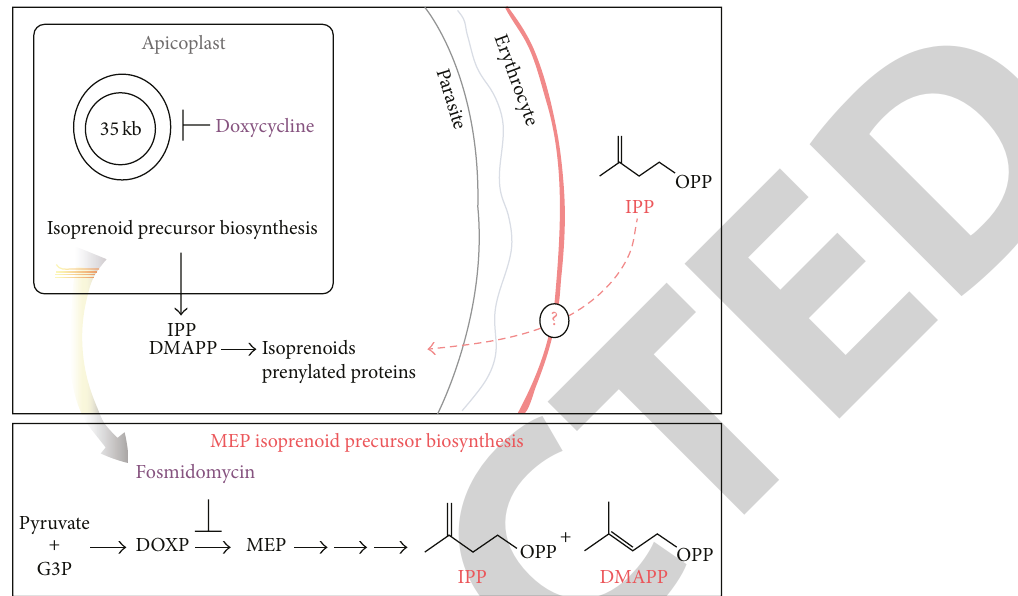
Figure 1: The role of the apicoplast in production of isoprenoid precursors, IPP and DMAPP, which are exported into the cytoplasm and used to synthesize small molecule isoprenoids and prenylated proteins. P. falciparum is unable to synthesize isoprenoid precursors either due to inhibition of the biosynthetic pathway by fosmidomycin or loss of the apicoplast following doxycycline inhibition which can be chemically rescued by addition of exogenous IPP. The exogenous IPP enters the host cell through unknown membrane transporters and fulfills the missing biosynthetic function